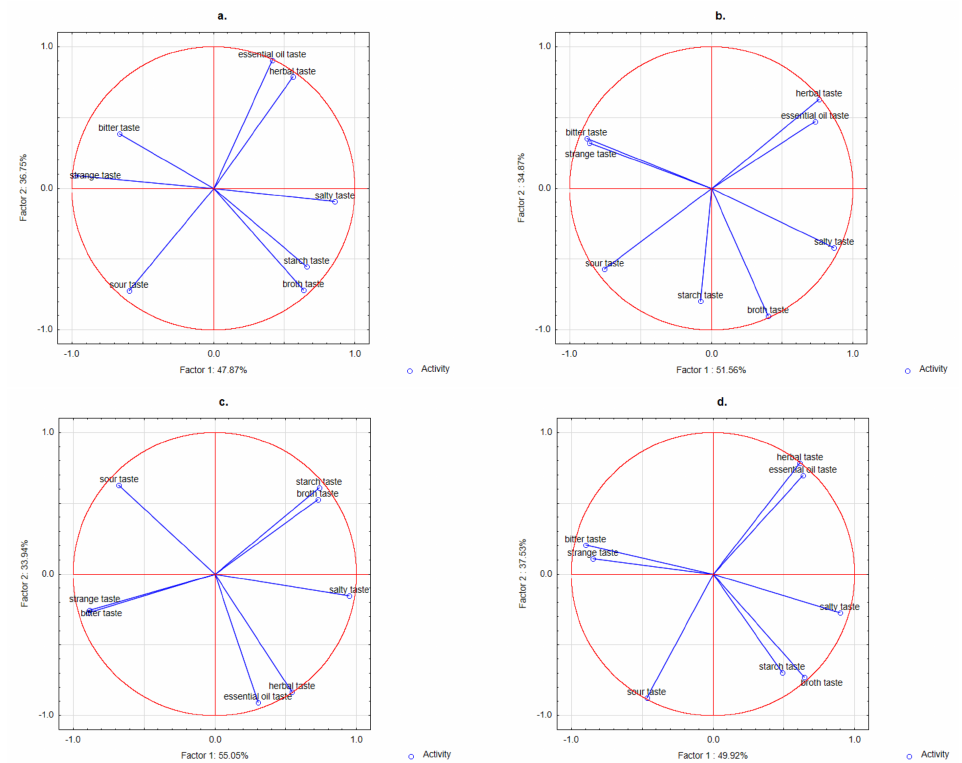
Figure 3. Principal component analysis (PCA) plots of data from sensory profiling of extruded snacks with addition of fermented red or broad beans/hull and with herbs/species (0.5%), and without the addition of herbs/spices (Control): ( a ) fermented ground red bean seeds 50%; ( b ) fermented red bean hull 10% panel; ( c ) fermented ground broad bean seeds 50%; ( d ) fermented broad bean hull